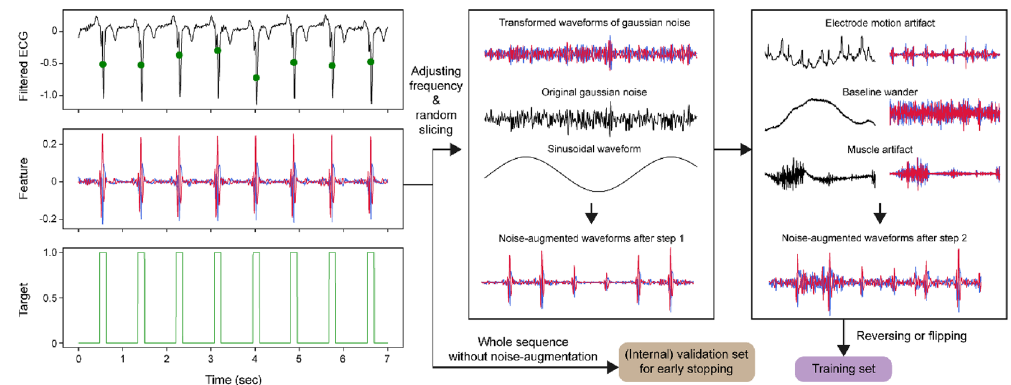
Figure 3. The schematic plot of a noise-augmented waveform generation. The ECG record was derived from patient I54 in the INCART database. Peak positions with 150 ms duration are filled as one and prepared for the target. Detail coefficients of SWT level 4 decomposition (red) and the first derivatives (blue) were prepared for feature